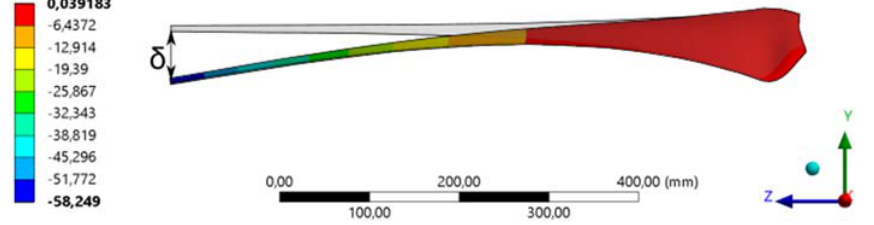
Figure 11. Blade tip deflection δ (in mm).